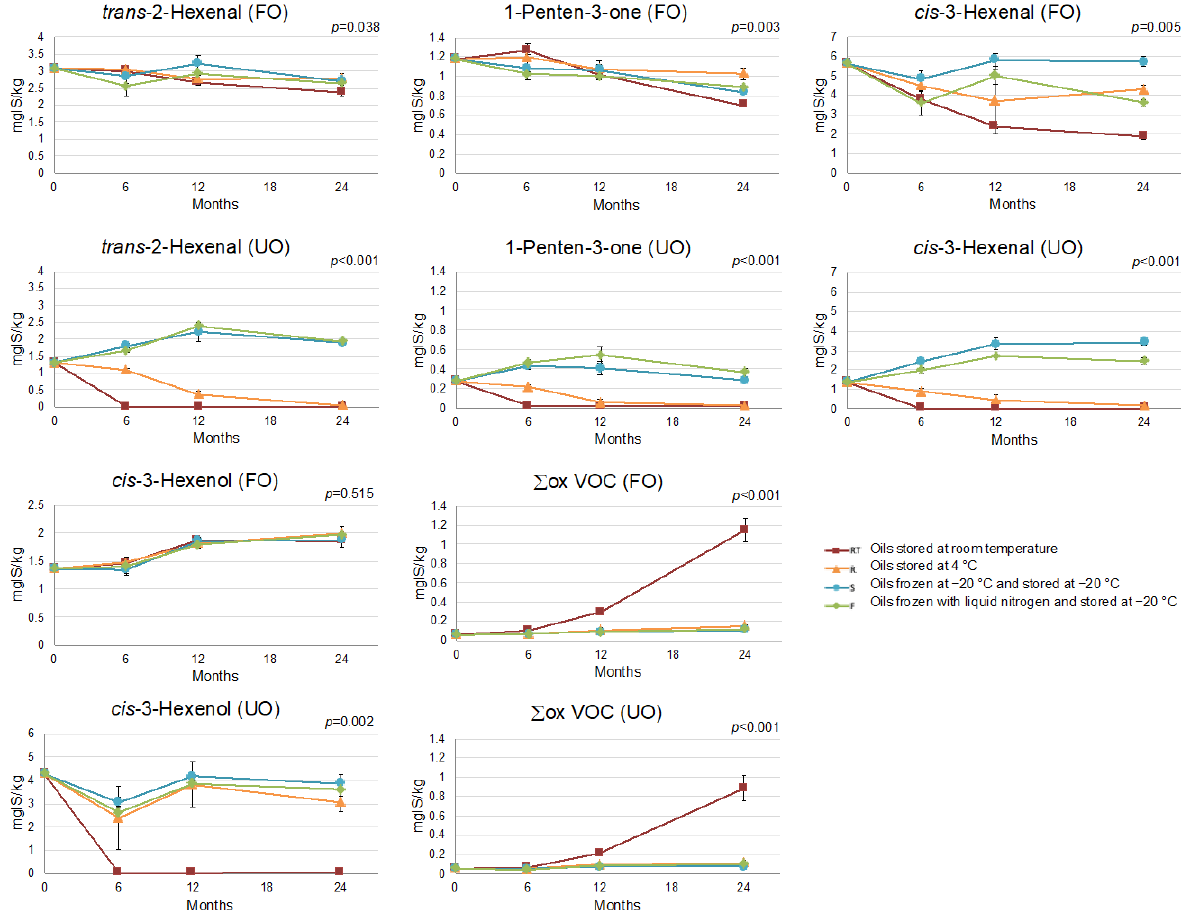
Figure 3. Interaction plot between storage conditions and time for trans -2-hexenal, 1-penten-3-one, cis -3-hexenal, cis -3-hexenol content and the sum of volatile oxidation products ( Σ ox VOC: octane, 1-octene, heptanal, compound with m/z 81, 95, 109, 124, according to Vichi et al. [56], octanal, 2-heptenal, nonanal, 2,4-heptadienal) of the filtered (FO) and the unfiltered (UO) oils. p ≤ 0.05 indicates significant interaction between the two factors (storage conditions and storage time). Error bars correspond to the standard deviation.